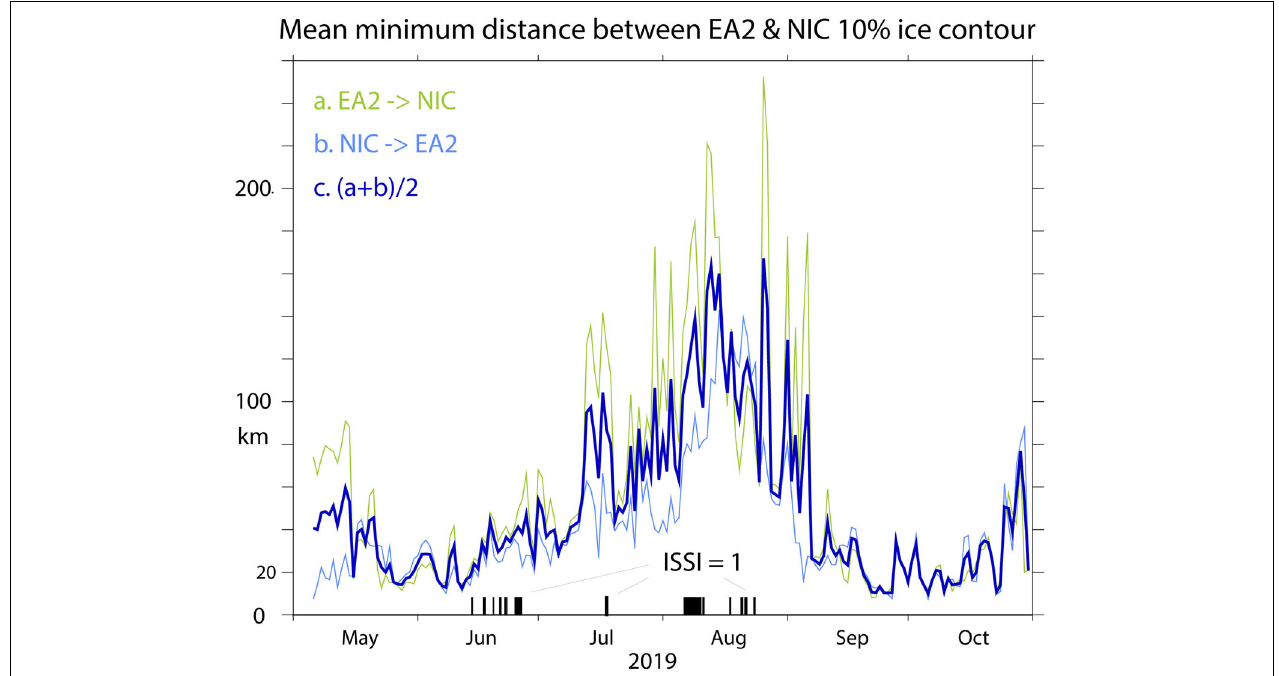
FIGURE 6 | Mean minimum-distances between the 10% ice concentration contour based on the NIC analysis and EA2 data. Vertical lines on the time axis mark times when ISSI = 1. ISSI = 0 during times unmarked by such vertical lines.